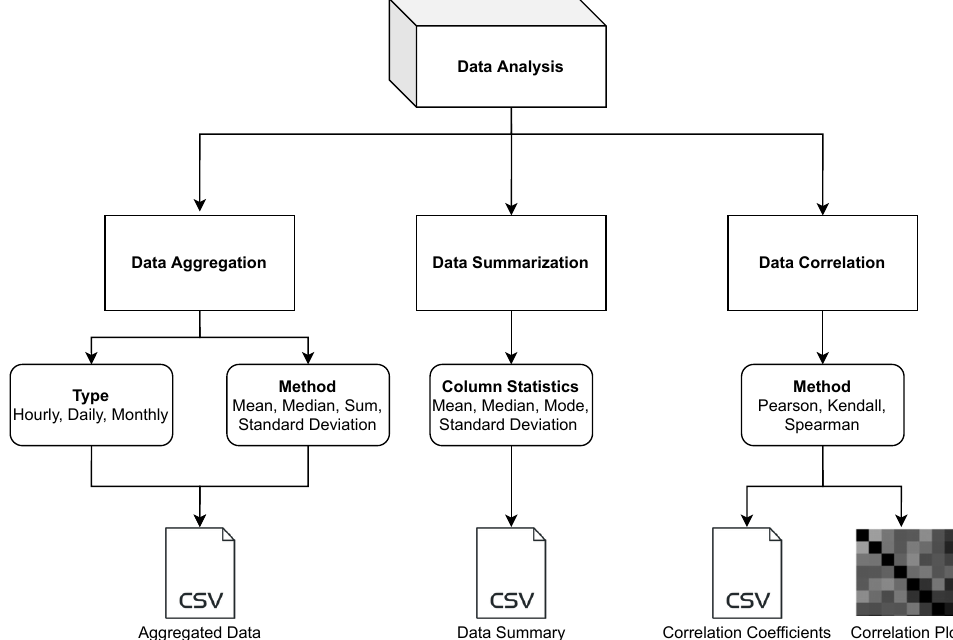
Figure 3. Data analysis workflow showing different functions, options, and